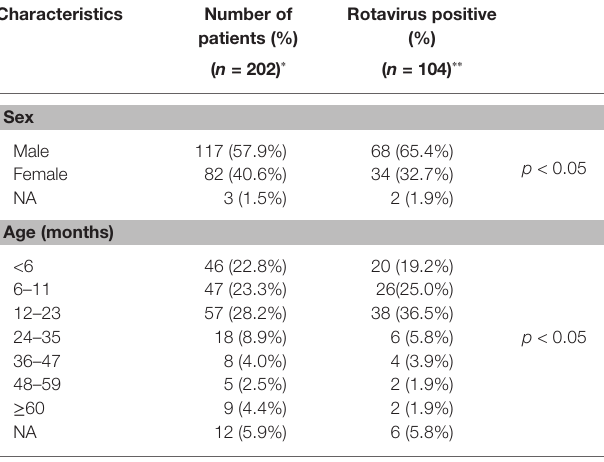
TABLE 2 | Age- and sex-specific prevalence of rotavirus infection in 2016–2018 in West Nusa Tenggara, South Sumatera, and West Papua.